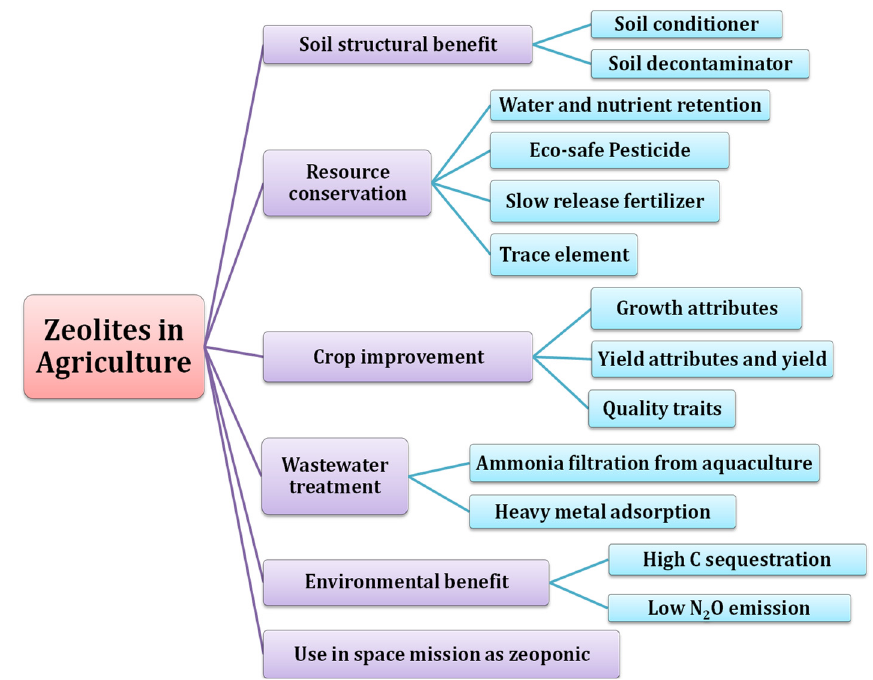
Figure 1. Multidimensional Uses of Zeolites in Agriculture.